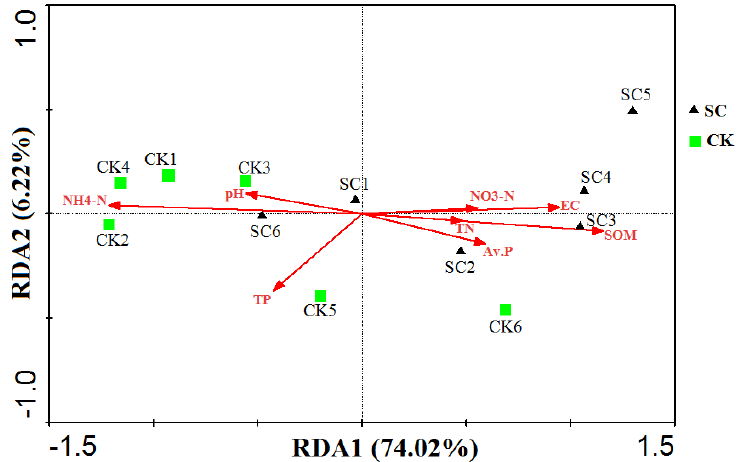
Figure 4. PLS-DA score plot of the relative abundances of diazotroph at the genus level associated with CK and SC. Abbreviations: SC, grasslands invaded by S. chamaejasme ; CK, uninvaded grasslands.